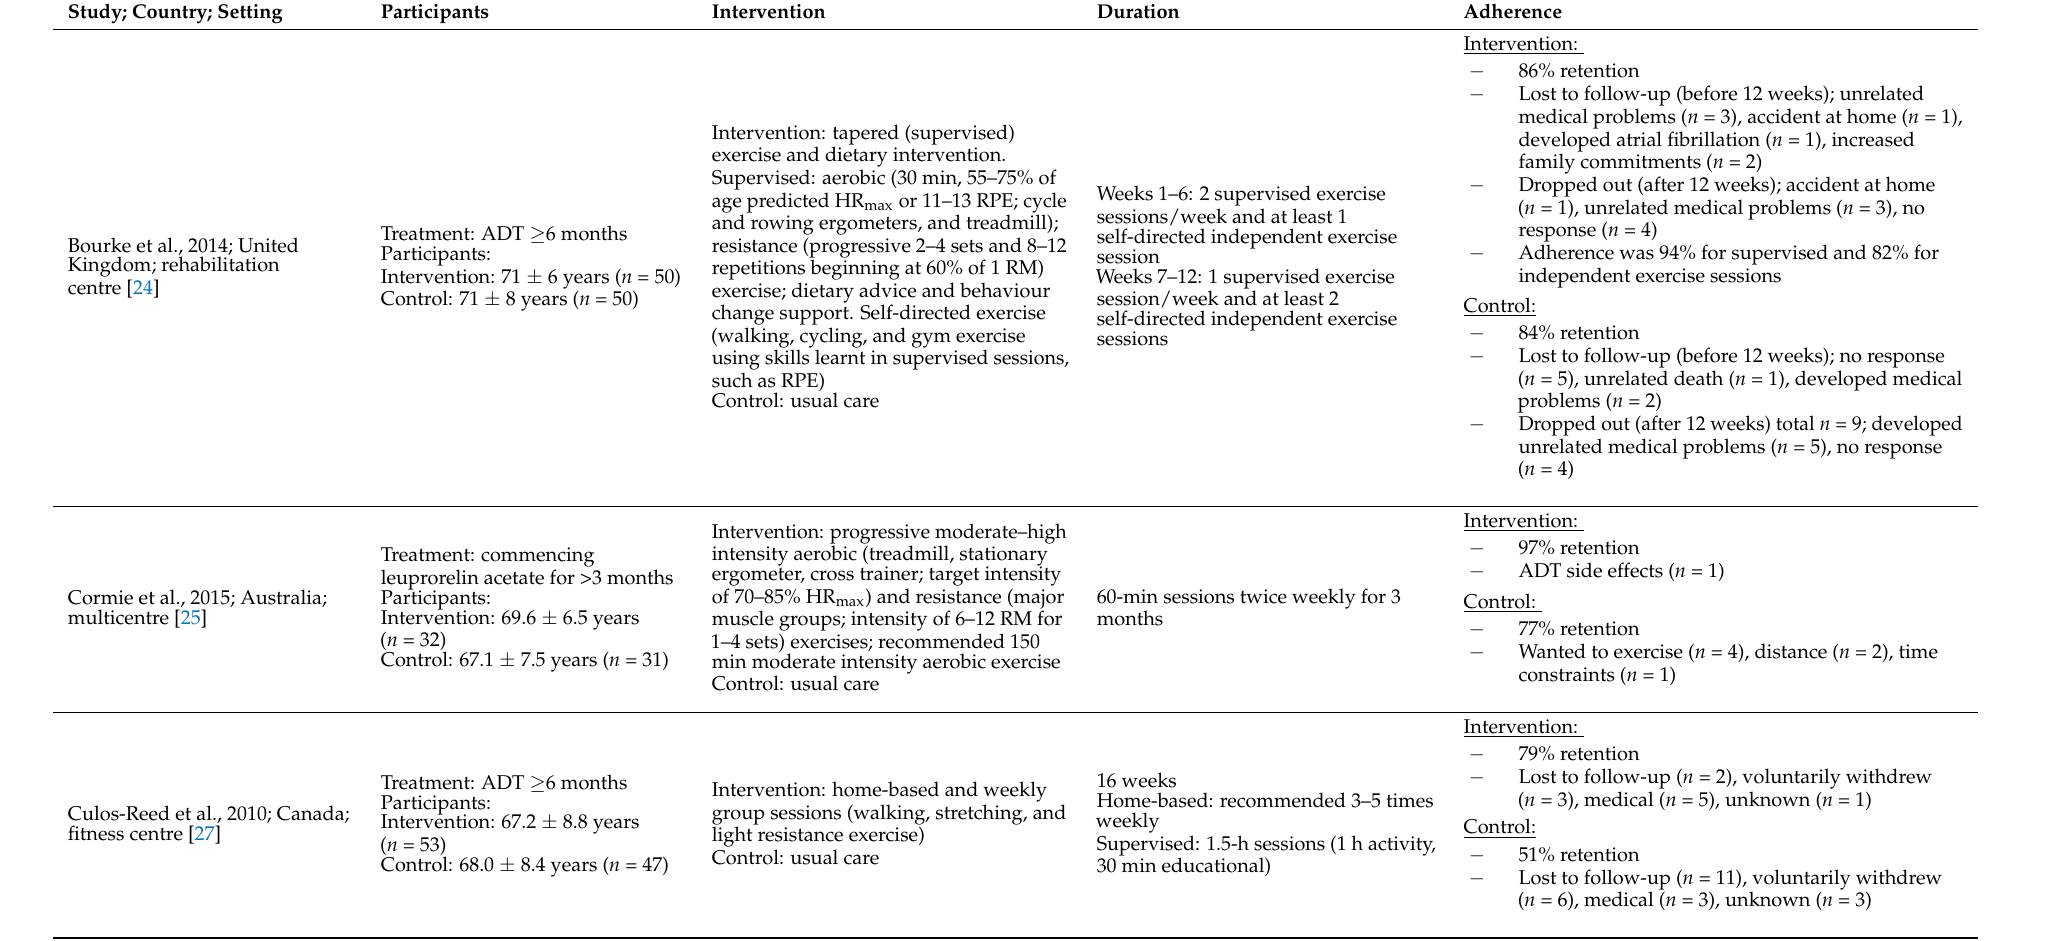
Table 1. Quantitative Studies Summary ( n = 23 articles from n = 19